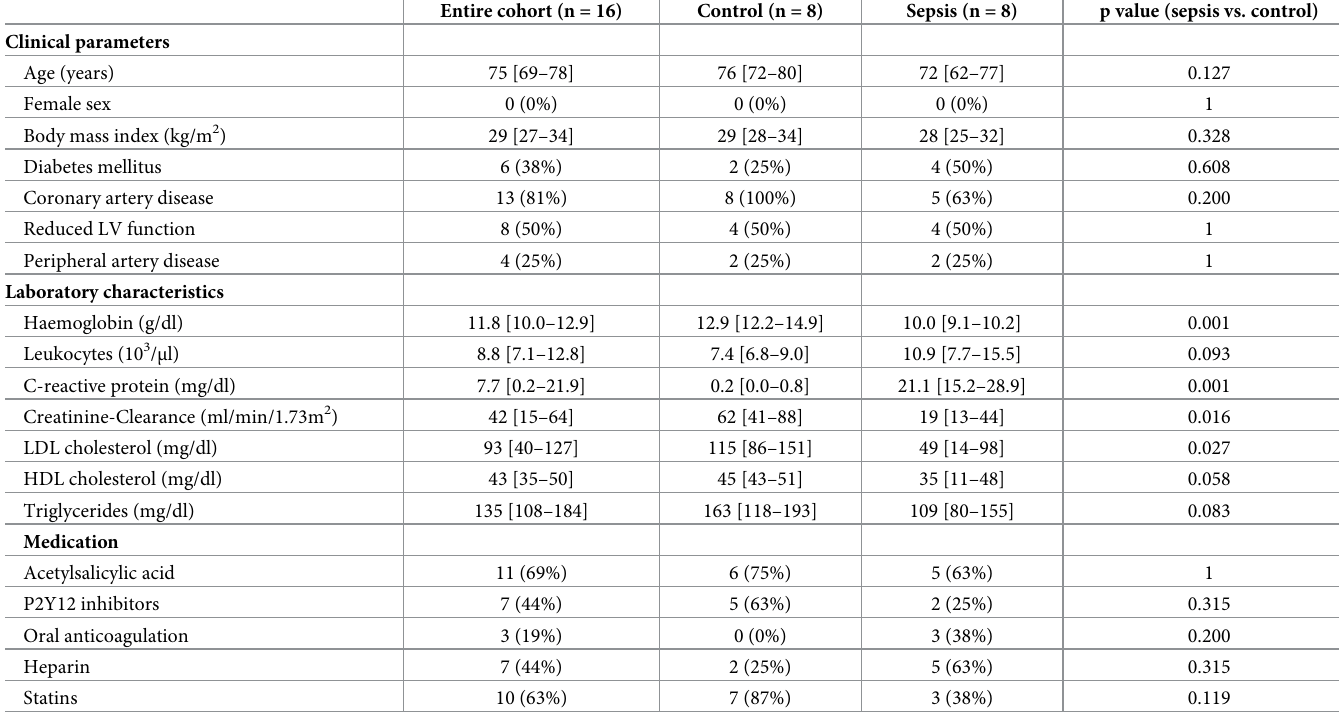
Table 1. Patient characteristics. Entire cohort (n = 16) Control (n = 8) Sepsis (n = 8) p value (sepsis vs.